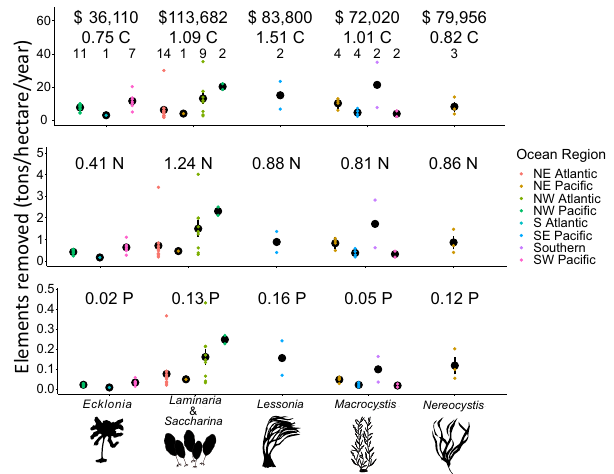
Fig. 3 | Annual value of the carbon, nitrogren, and phosphorus removal ser- vices provided by kelp forests. The mean yearly removal of carbon (C), nitrogen (N), and phosphorus (P) in tons per hectare per year. The black dots represent the mean value for the genus in that region, the error bars are the standard error. The currencyisinthousandsofinternationaldollarsfortheyear2020andisgivenasan average value for each genus. The top text dollar values are the combined eco- nomic value for the removal of all three elements. Sample sizes (unique location- time measurement) are presented above eachpoint. Imagecredit: Tim Carruthers, Integration and Application Network (ian.umces.edu/media-library) for the Ecklo- nia , Laminaria, Lessonia, Macrocystis, Nereocystis images.